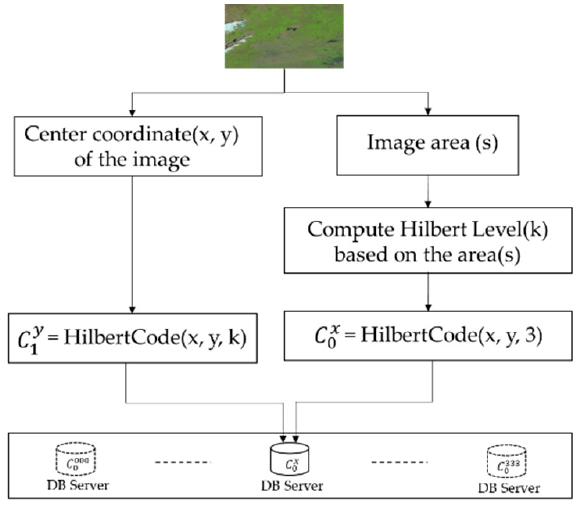
Figure 8. Remote sensing image encoding and storage.